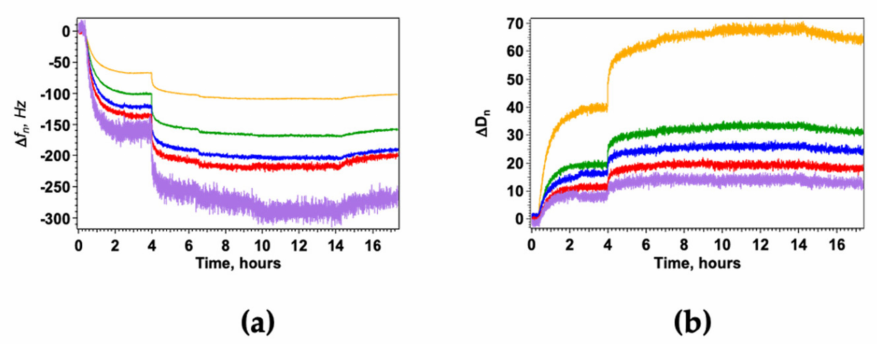
Figure 2. HWL-N adsorption on GO-AgNC/NS nanostructures monitored by QCM measurements. ∆ f ∆ D n ( a ) and n ( b ) are the frequency shift and the dissipation factor for the fundamental frequency (yellow) and for the third (green), fifth (blue), seventh (red), and 11th (purple) overtones. The addition of increasing concentrations of HWL-N for 1 × 10 − 8 M < [HWL-N] < 1 × 10 − 5 M was followed by water-rinsing; temperature was kept constant at 20 ◦ C for all measurements.